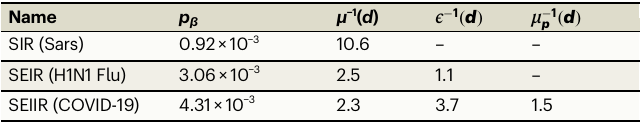
Table 2 | List of parameters for the epidemic models here